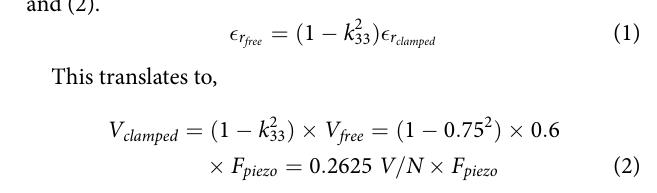
TABLE 1 | Geometric and functional specifications of the SPA skin prototype . SPA skin